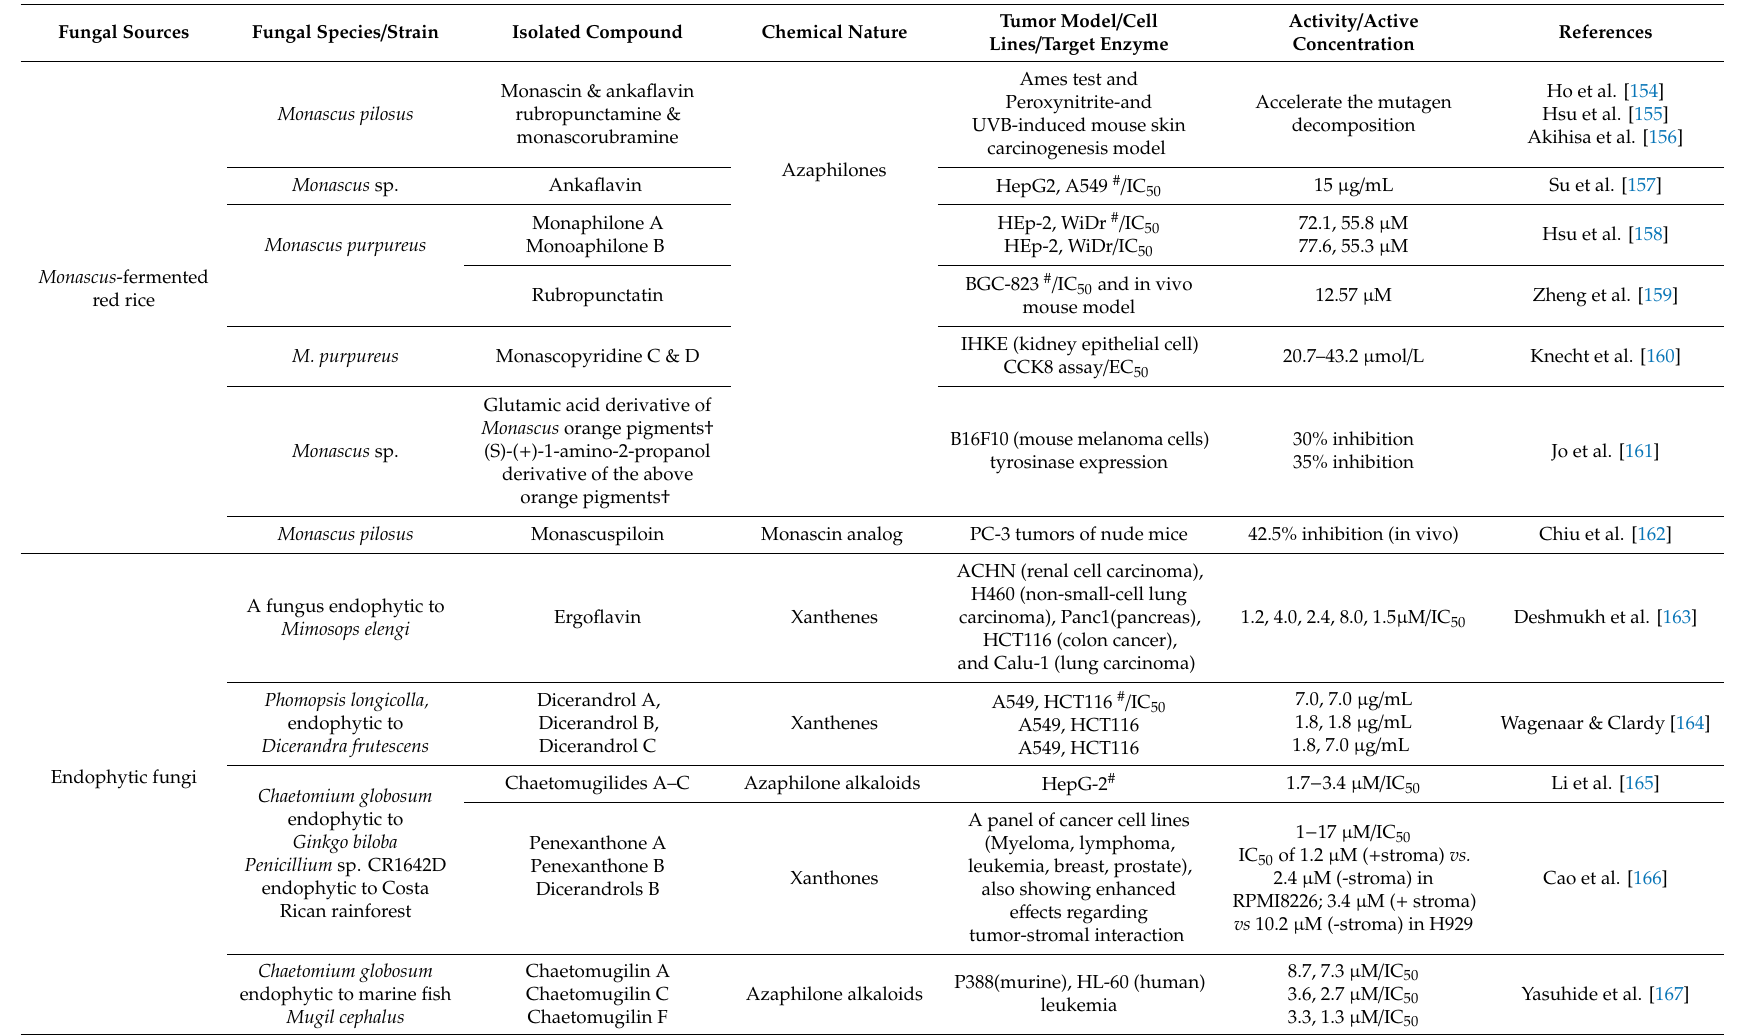
Table 1. Fungal pigments with antitumor